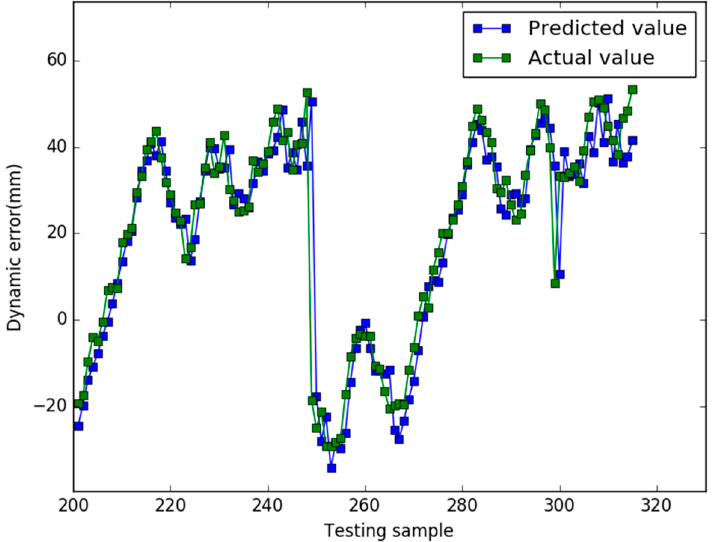
Figure 7. Predicted results of the GSO-SVM (case2).